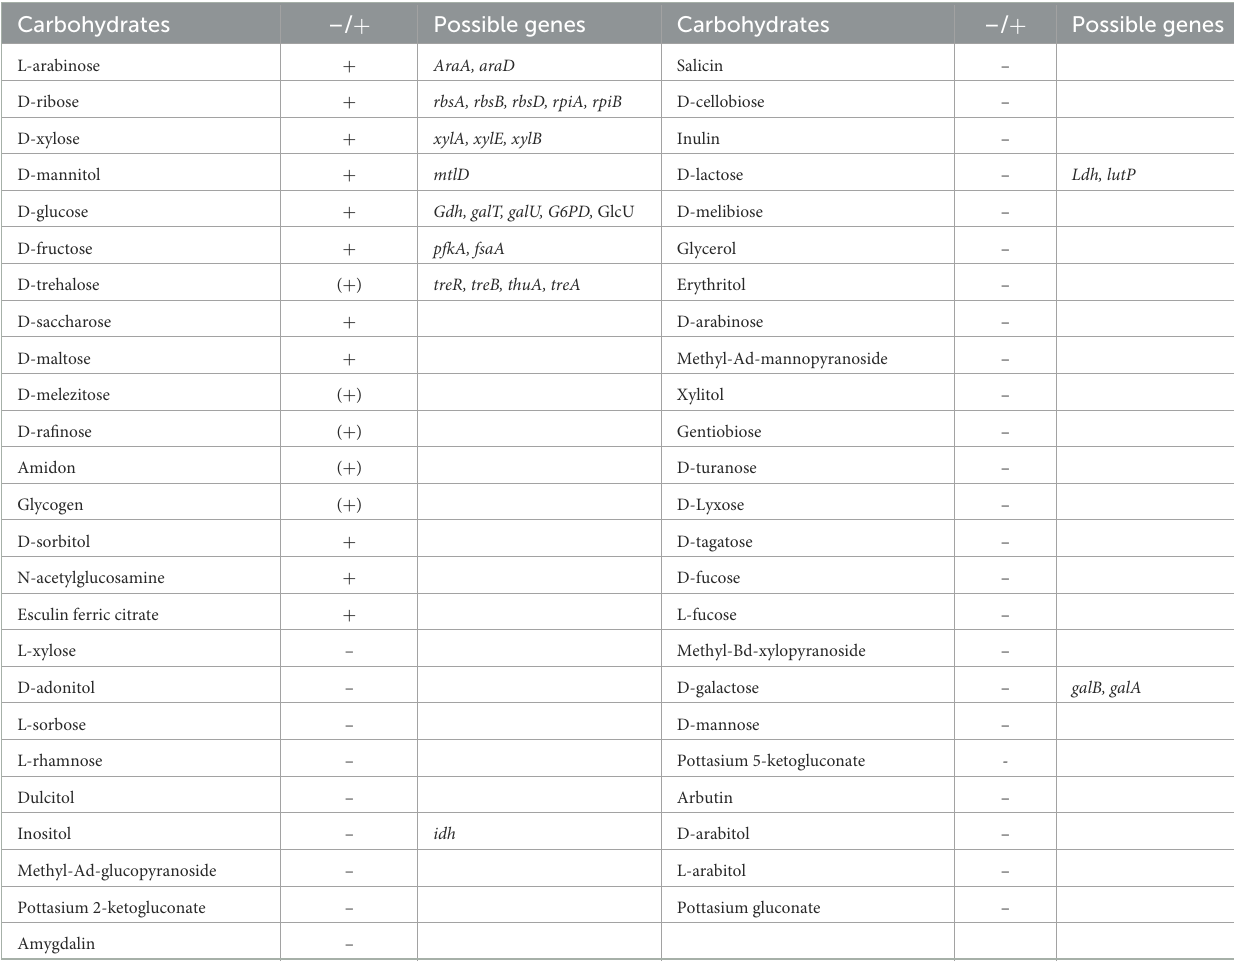
TABLE 1 Renuspore ® can ferment 11 carbohydrates using API 50 CH strips, and the genes associated with the fermentation were indicated from the genomic analysis.